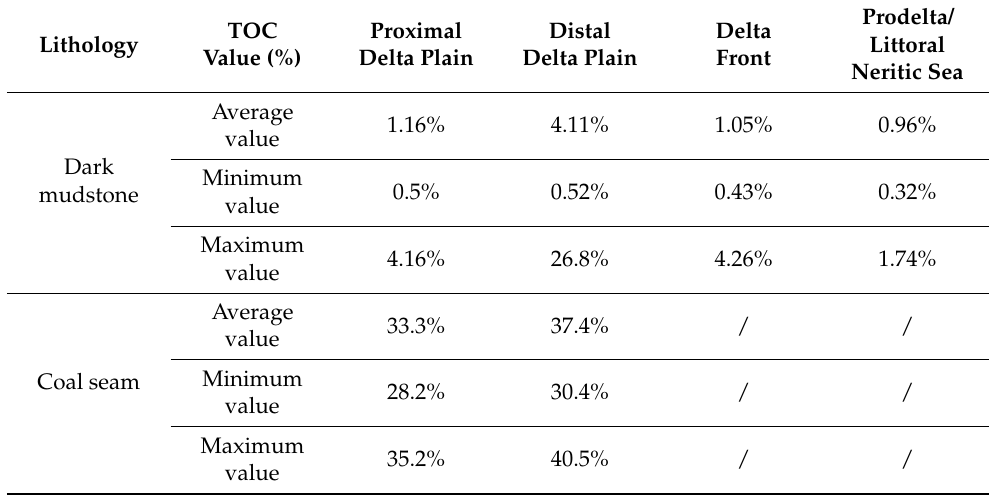
Table 2. Total organic carbon (TOC) values of the dark mudstone and coal seam in different delta subfacies of the Mungaroo Formation in the